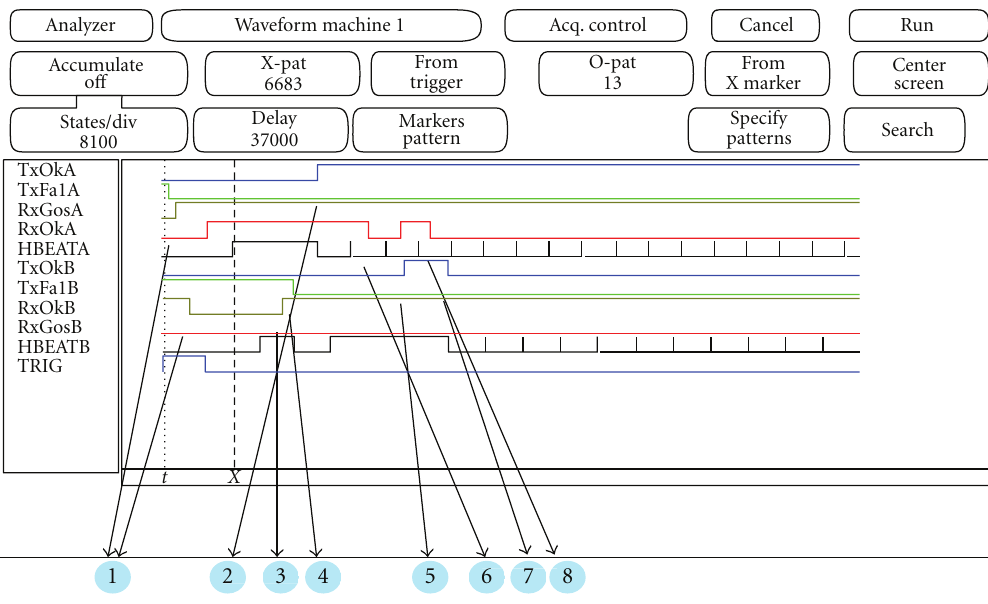
Figure 15: Multihop signal test.